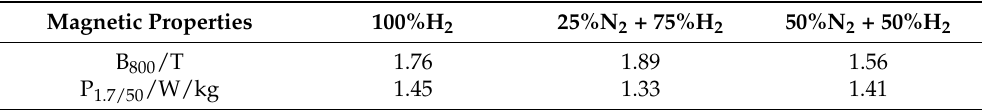
Table 4. Magnetic properties of grain-oriented silicon